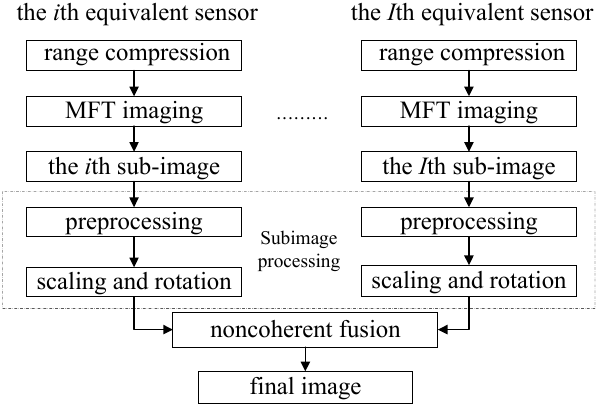
Figure 4. The complete processing